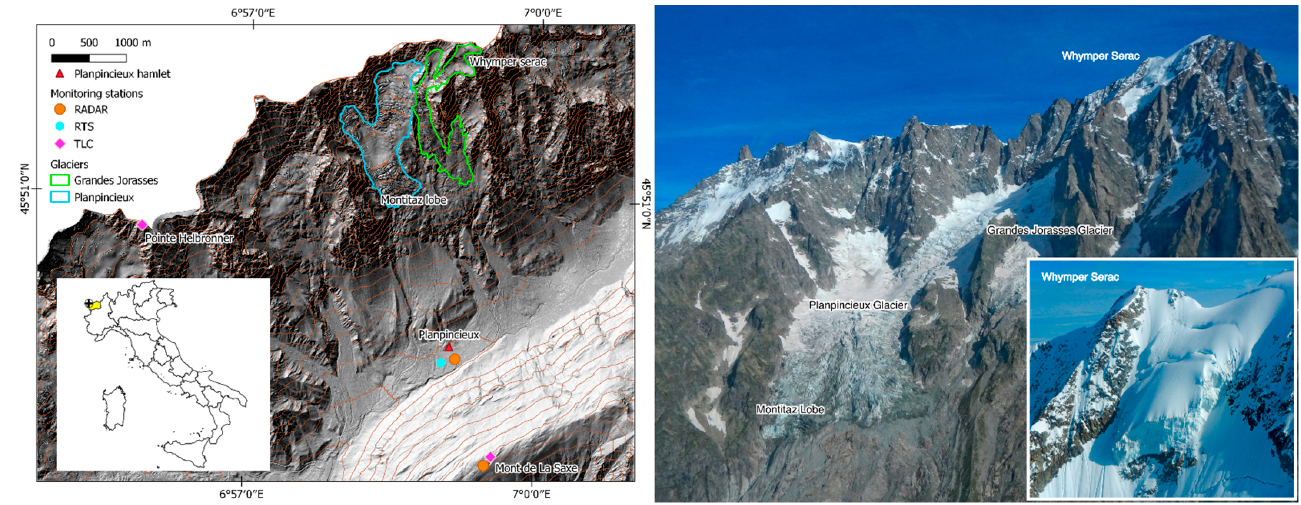
Figure 1. Left panel: overview of the study area. Right panel: Planpincieux and Grandes Jorasses glaciers. In the white box, a closer perspective of the Whymper Serac is shown.